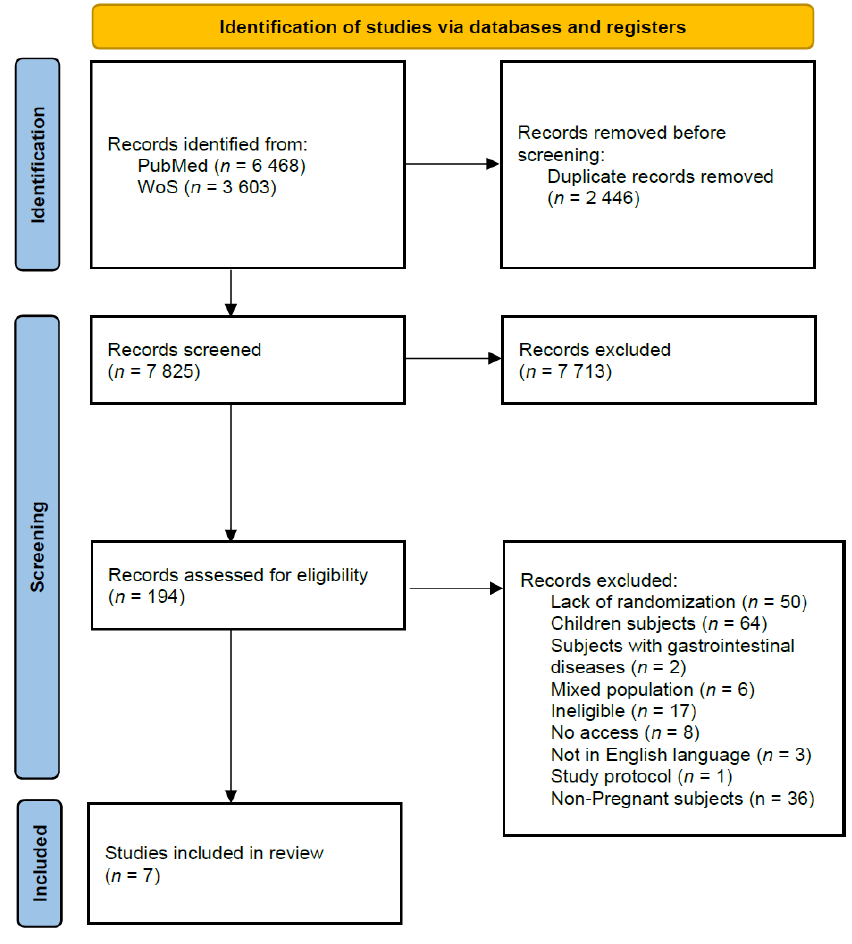
Figure 1. The identification, screening, and inclusion procedure of the studies available in PubMed and Web of Science